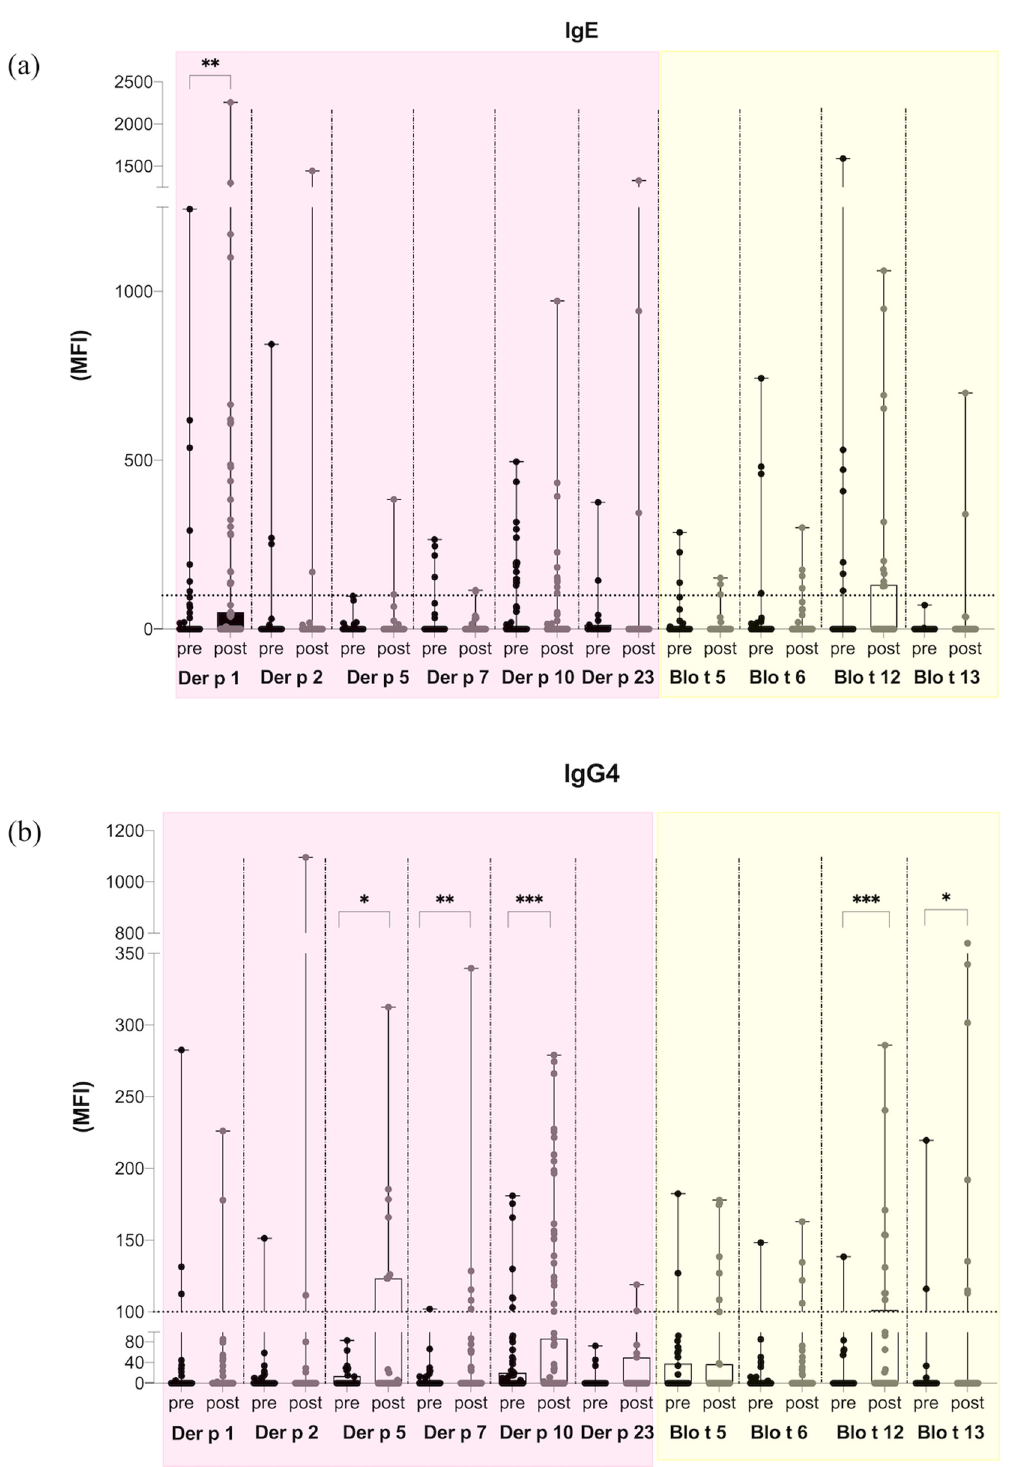
10, Blo t 12, and Blo t 13 (Figure 2b). In line with the enhancement of IgG4 epitope diver- sity, SLIT also induced a higher antibody binding capacity to the allergen peptides.